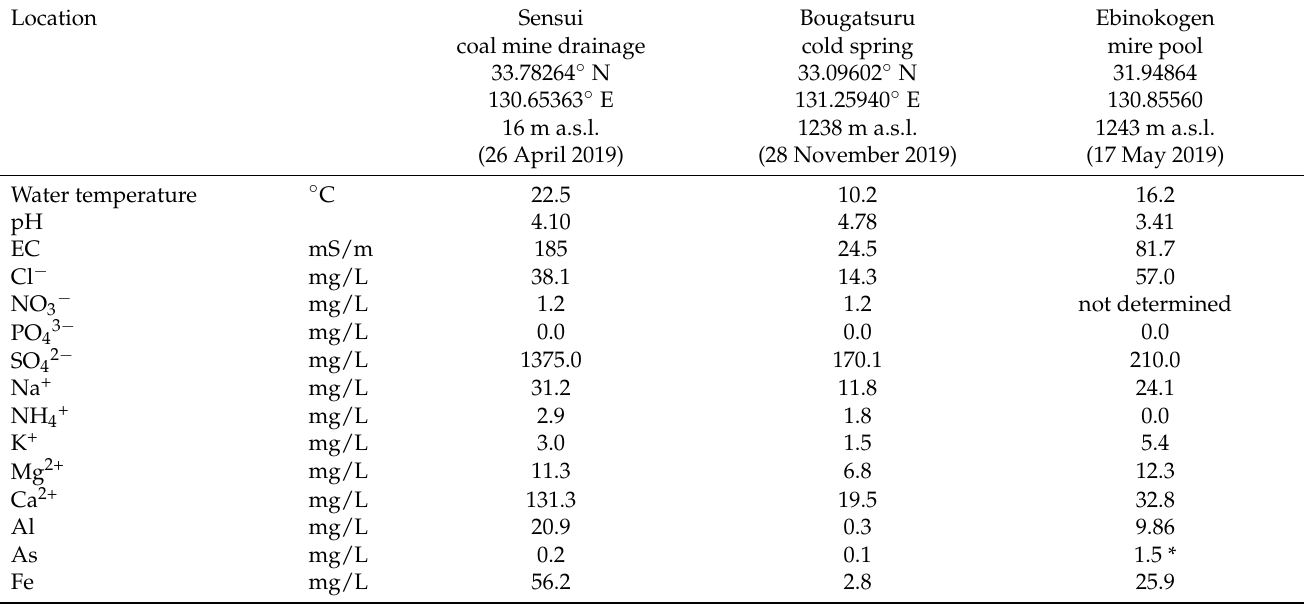
Table 1. Quality of stream water at the habitats of Euglena mutabilis in Sensui, Bougatsuru, and Ebinokogen. * analyzed by AH.